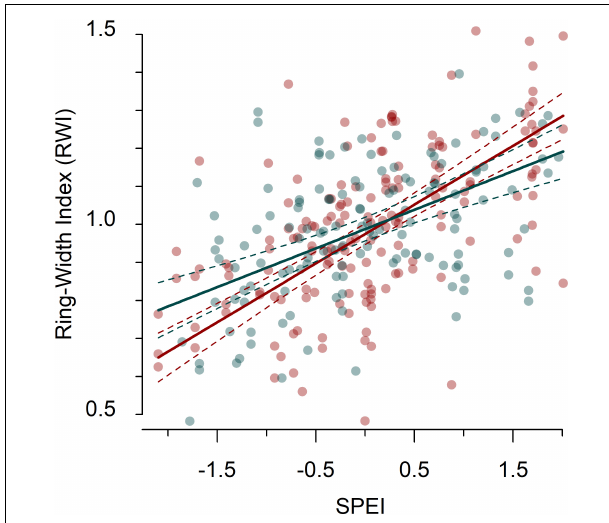
FIGURE 2 | Relationship between residual tree-ring width chronologies (RWIres) and drought (the 12-month SPEI in August) in dry and wet sites according to the fitted linear mixed-effect models. Blue symbols and lines indicate populations sampled in wet sites and red symbols and lines indicate populations sampled in dry sites. The thick solid line shows the effect of SPEI on RWIres (and 95% confidence intervals are plotted as dashed lines).